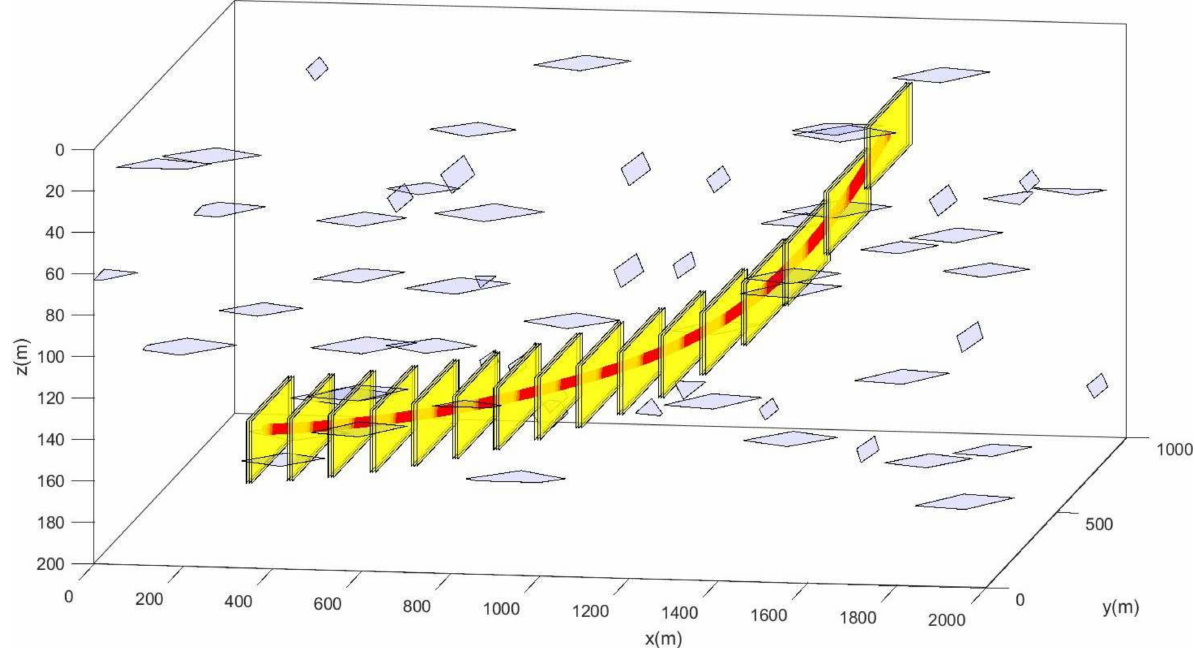
Figure 11. Tilt-up well demonstration with both hydraulic fractures (yellow rectangle) and natural fractures (gray rectangle); the well trajectory is represented by the red